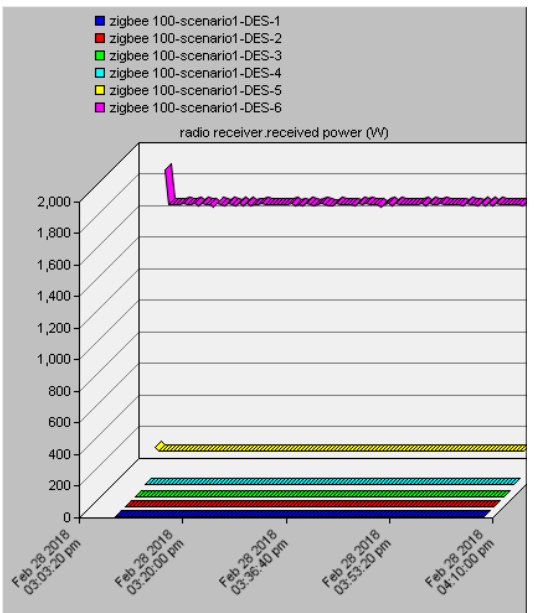
Figure 2. Fluctuations in Received Power according to the changes in Transmitted Power. (X axis: Time, Y axis: Transmitted power).